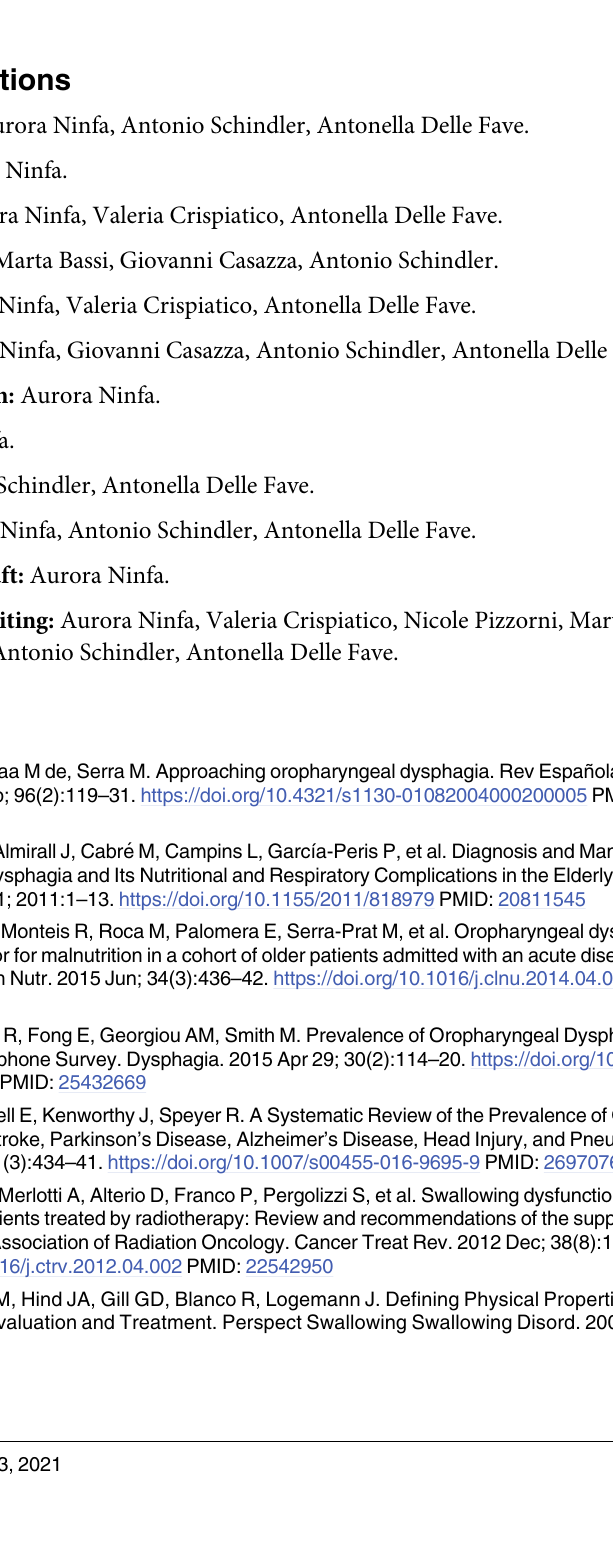
S5 Table. Audit trail of OD-related needs